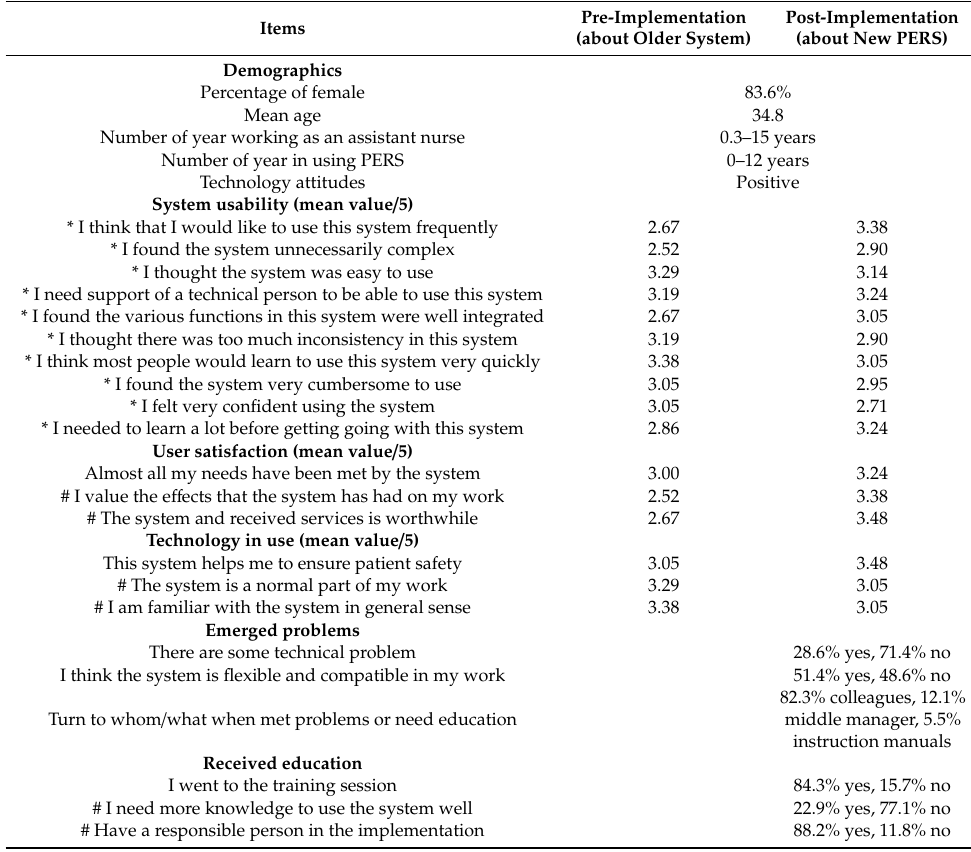
Table A1. Survey Questions and